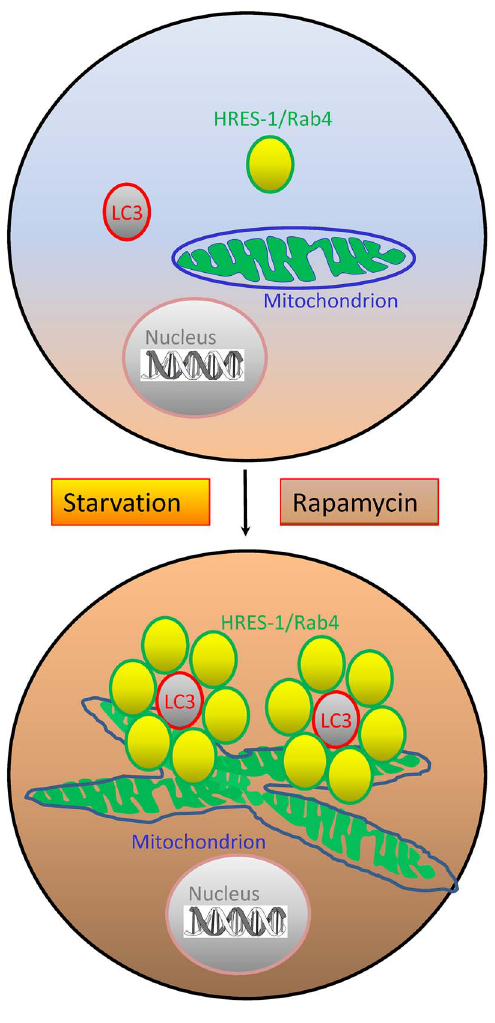
Figure 8. Schematic diagram of the impact by HRES-1/Rab4 on autophagy. HRES-1/Rab4 promotes the formation of LC3 + autophago- somes, the accumulation of mitochondria, and their colocalization during autophagy induced by starvation or treatment with rapamycin. LC3 + autophagosomes are encircled by HRES-1/Rab4 + endosomes. The formation of interconnected mitochondrial tubular networks is enhanced by HRES-1/Rab4 Q72L upon starvation.